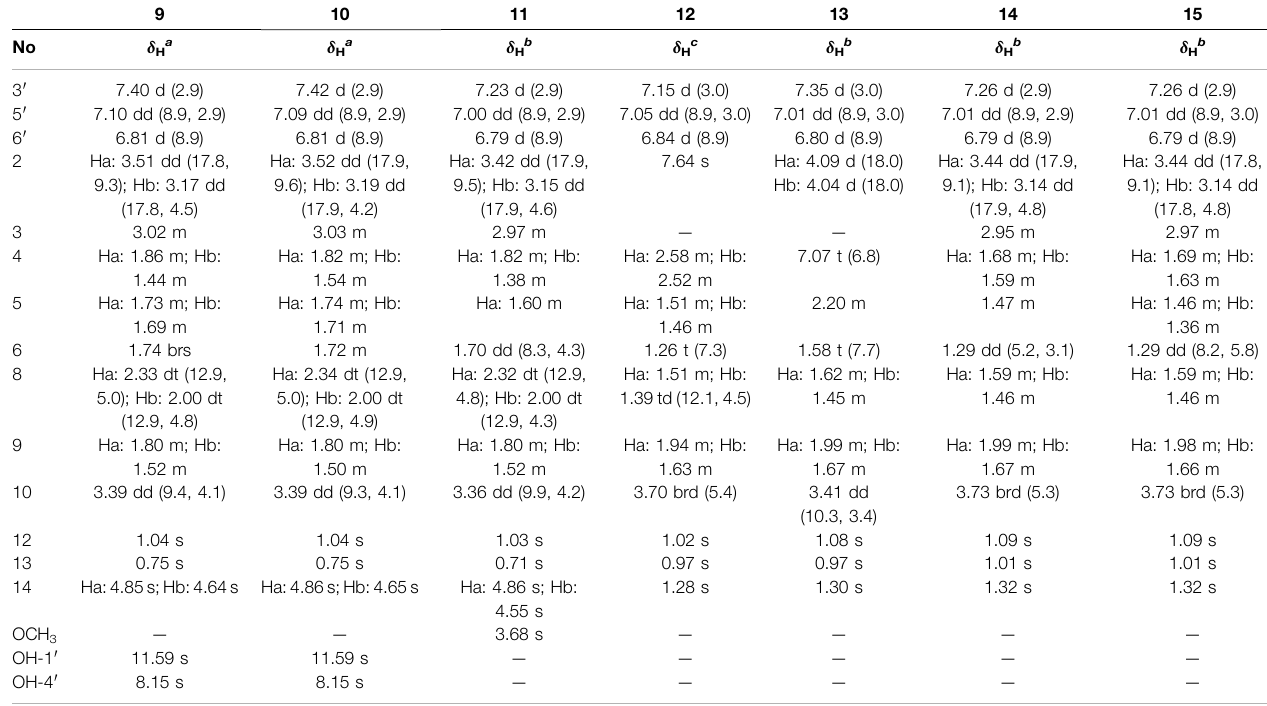
TABLE 3 | 1 H NMR data of 9 – 15 in methanol- d 4 ( δ in ppm, J in